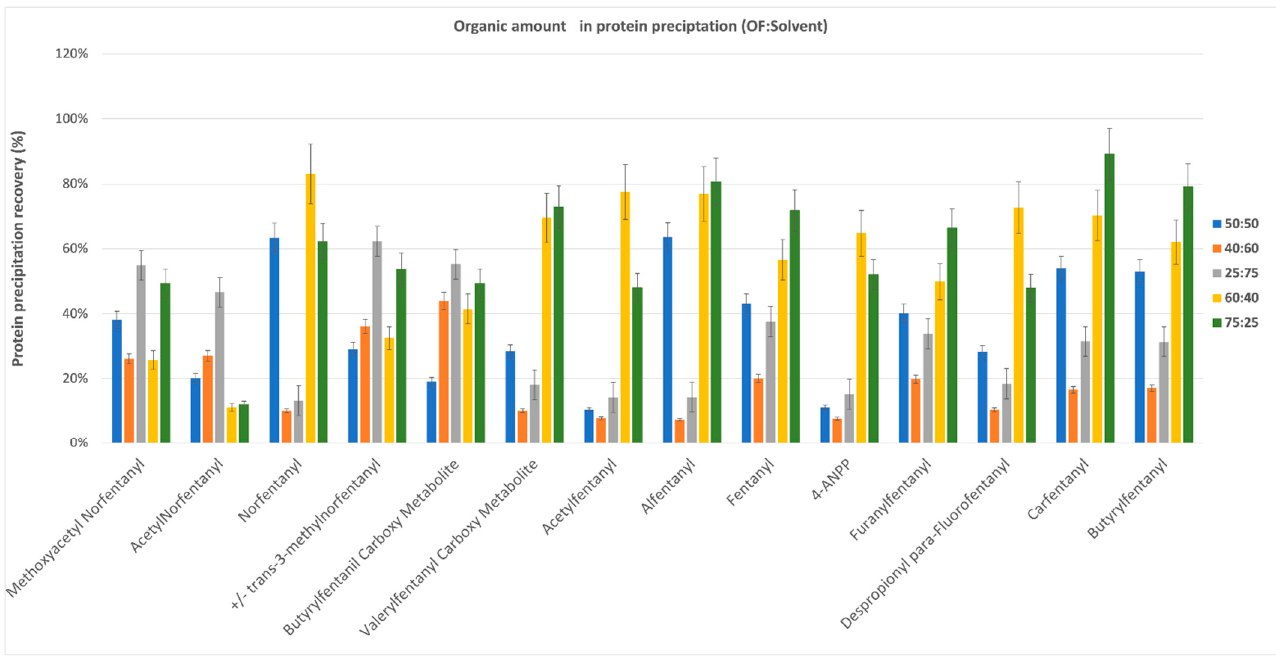
Figure 2. Different ratio between OF and solvent tested for the protein precipitation, i.e., 50/50, 40/60, 25/75, 60/40, 75/25 (OF/solvent).